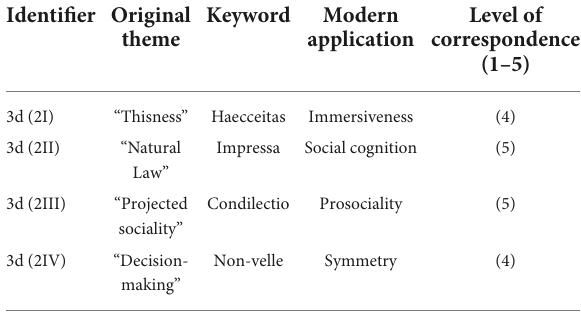
TABLE 1 Medieval and modern concepts of